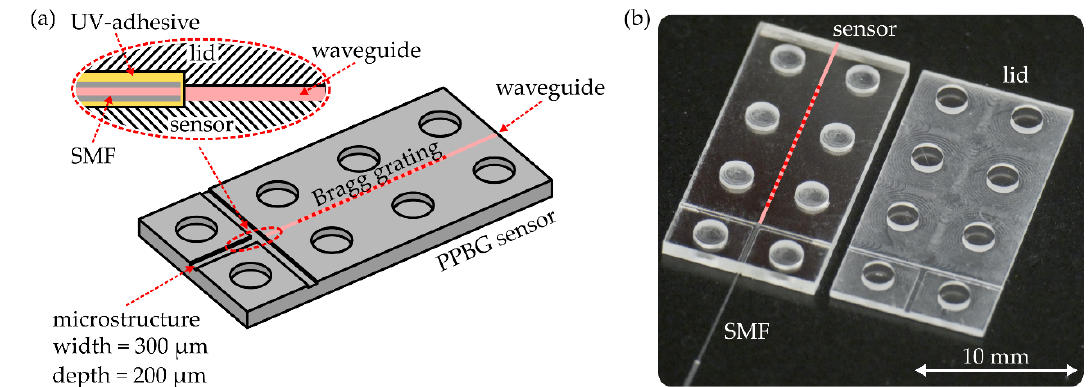
Figure 2. ( a ) Schematic of the microstructured sensor substrate. The zoom in (upper left) depicts a cross section of the final fiber-to-chip coupling configuration. ( b ) Photograph of the microstructured polymer planar Bragg grating (PPBG) sensor butt coupled to a single-mode fiber. The associated lid is subsequently mounted on top of the sensor substrate.